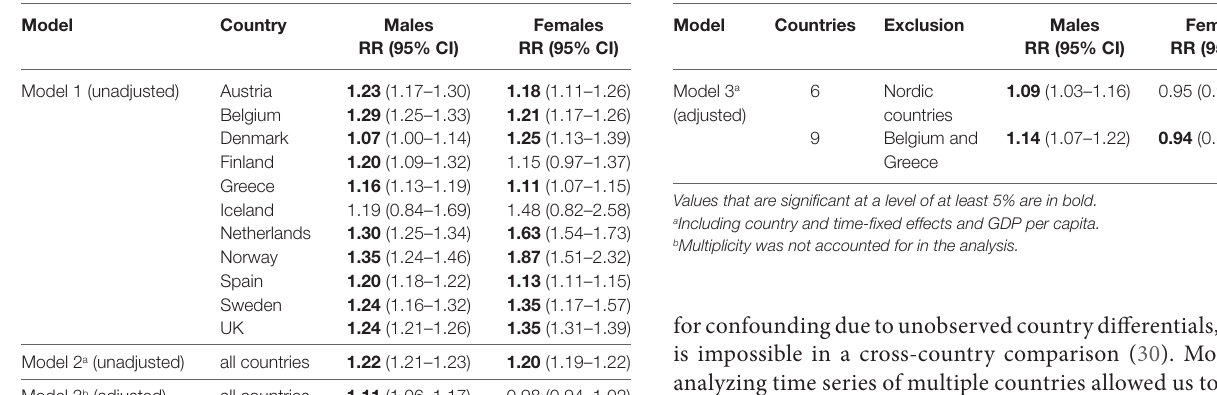
TaBle 2 | Relative effect of a 1-year change in life expectancy at age 75 on the renal replacement therapy prevalence at ages 75 + ( N = 110). c